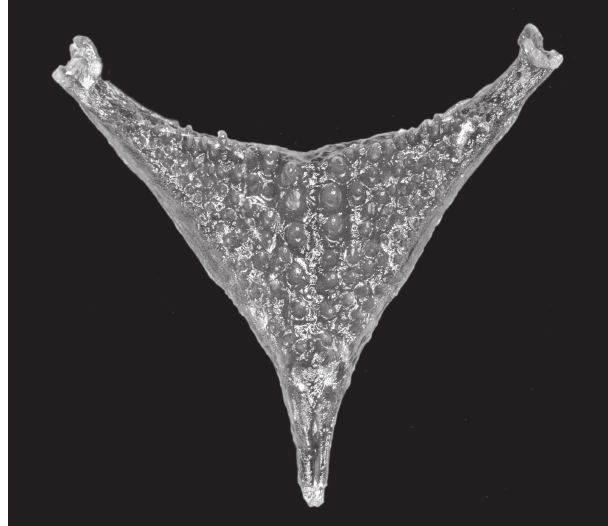
Fig. 3 . Pharyngeal tooth plate of Gymnogeophagus pelio- chelynion , 74.2 mm SL, UFRGS 8076, paratype. Dorsal view; anterior to bottom.